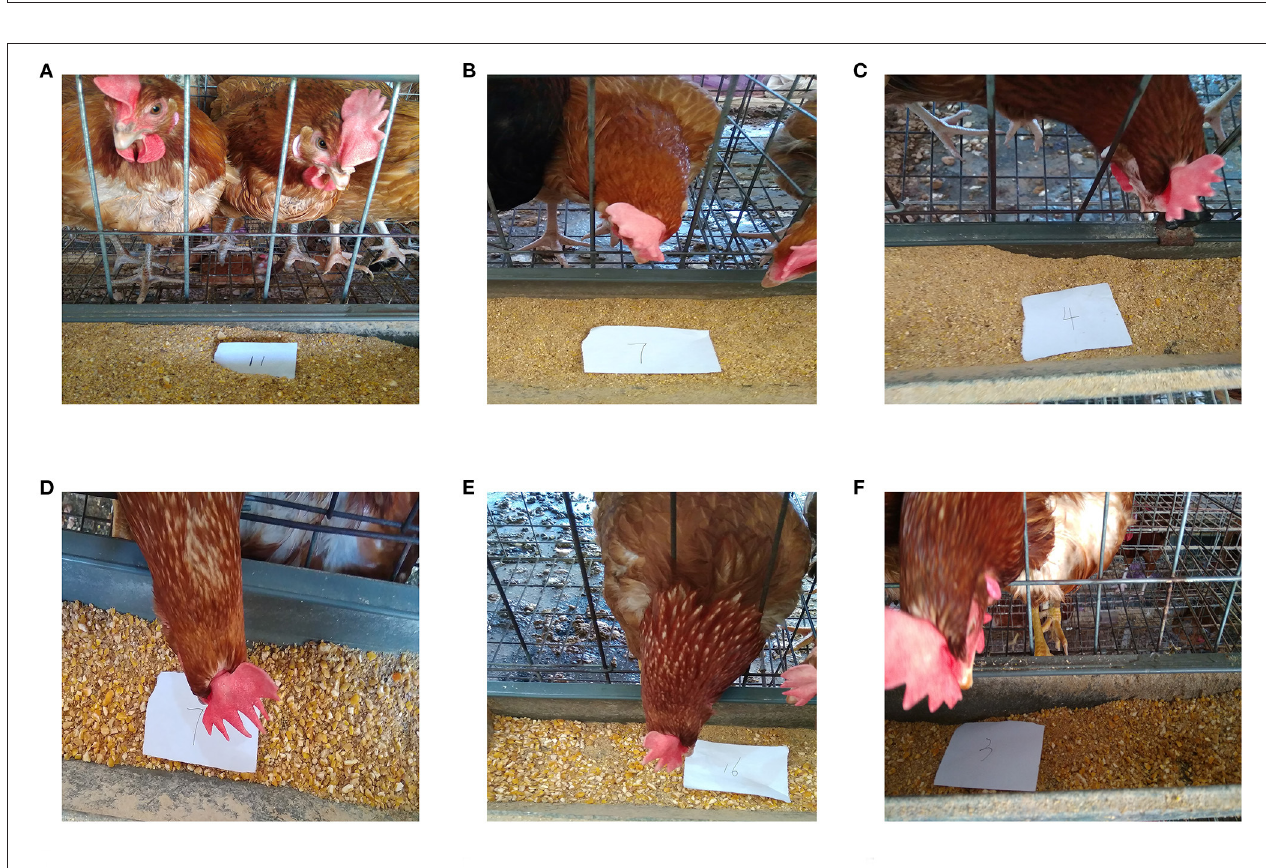
FIGURE 2 | Leftovers of Bian hens–20 weeks (BHT) and ISA Brown hens–20 weeks (IBHT). (A - C) Part of the powder feed remained in the BHT’s chute. (D-F) Part of the powder feed remained in the IBHT’s chute. Comparison of Gut Microbial Composition Among the Groups In BH, the relative abundances of the fiber-degrading genera Prevotellaceae_UCG-001 in the OL group (5.27%)